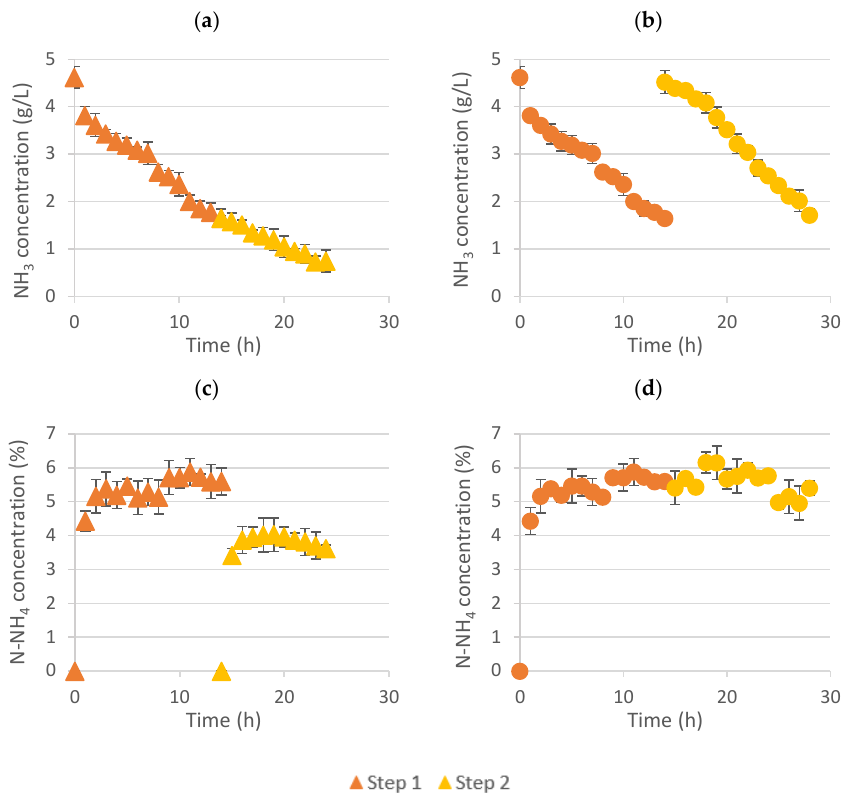
Figure 1. Ammonia concentration evolution over time in the feed tank when changing ( a ) the acid and ( b ) feed between steps (up). Nitrogen concentration achieved in the liquid fertilizer by changing the ( c ) acid or ( d ) feed solution between steps (down). Orange color implies one stage of LLMC (triangle for the feed side and circle referring to the fertilizer solution), while yellow color refers to experiments with two LLMC stages (triangle for the feed side and circle referring to the fertilizer